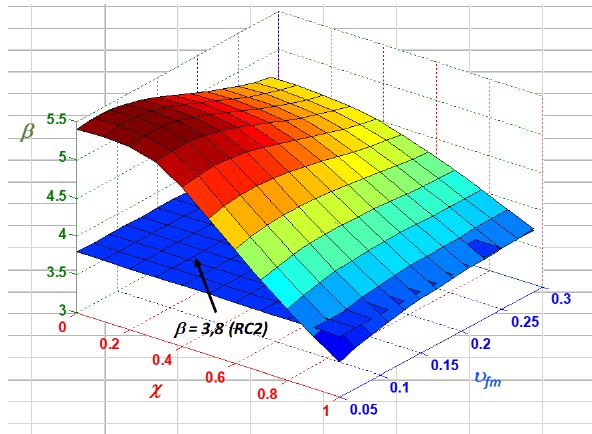
Figure 8: Area of relationship between the reliability index β , the load coeflcient χ and the coeflcient of variation v for the class A execution of works and the combination of the norm coeflcients according to formula 6.10a - reliability class